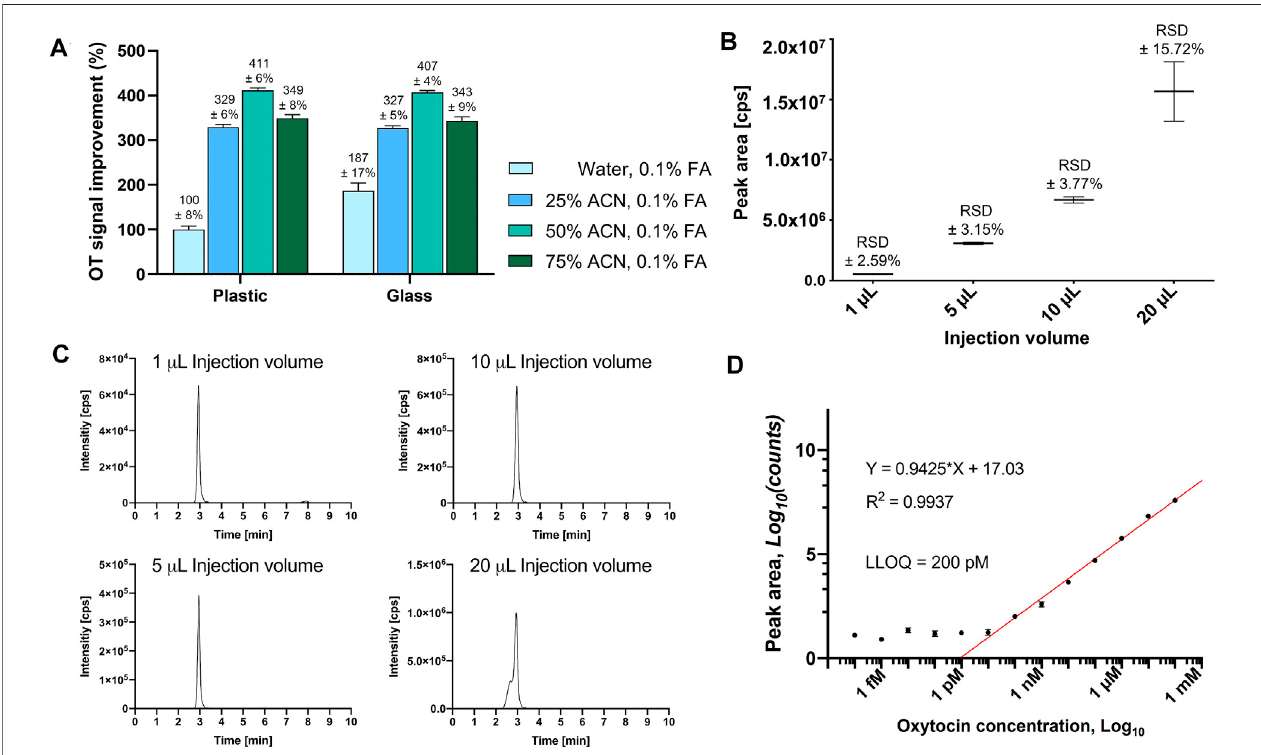
FIGURE 1 | Evaluation of HPLC vial adsorption, optimal injection volume and LLOQ of OT on an API4000 QTRAP. (A) OT MS peak area signal improvement of a 10 µM OT solution with different ACN concentrations from either plastic or glass HPLC inserts after 24 h, normalized to the signal of the OT solution in water, 0.1% FA, from a plastic HPLC insert. Results are presented as the mean percentage improvement ±SD; n = 3. (B) Evaluation of different injection volumes (1, 5, 10, and 20 μ L) of anOTstandardsolution(10 μ